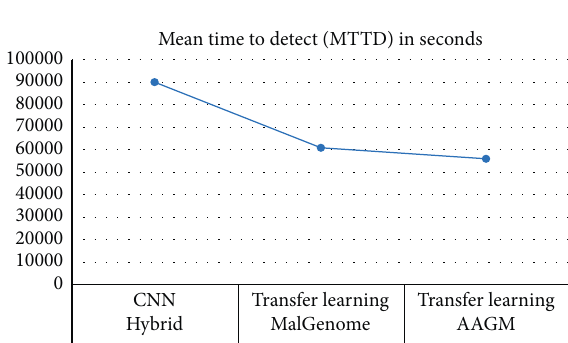
Figure 11: MTTD for CNN model and transfer learning model.